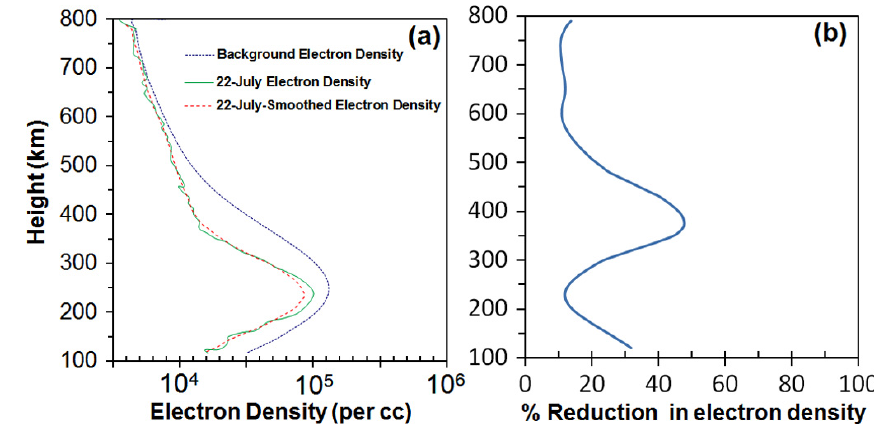
Fig. 3. (a) Variation of electron density profiles obtained from the FORMOSAT-3/COSMIC GPS-RO satellites over Indian zone for the eclipse day (22 July 2009) and the mean during quiet day. The smoothed electron density profile on the eclipse day (running mean) is also shown and (b) the percentage change in electron density compared to smoothed electron density profile of quiet mean value between 06:30 and 07:30LT over the Indian